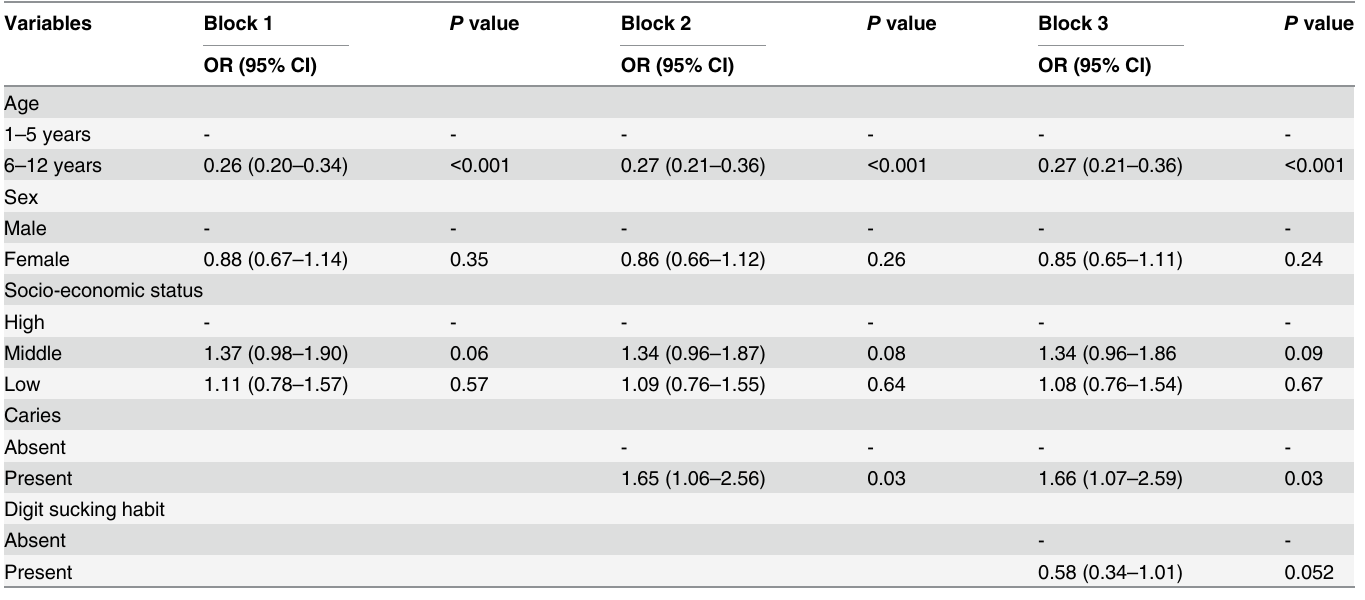
Table 5. Logistic regression determining predictors of poor oral hygiene in a sample of 983 children.